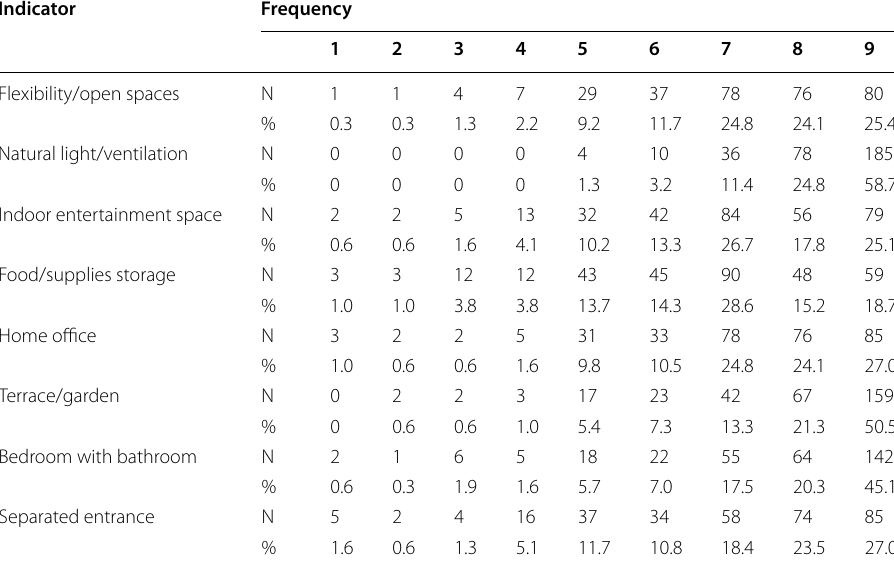
N number of participants; total number of participants